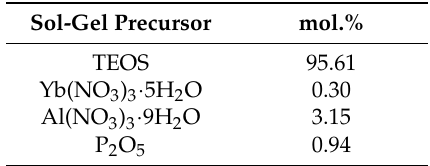
Table 2. Sol-gel precursor ratio in molar